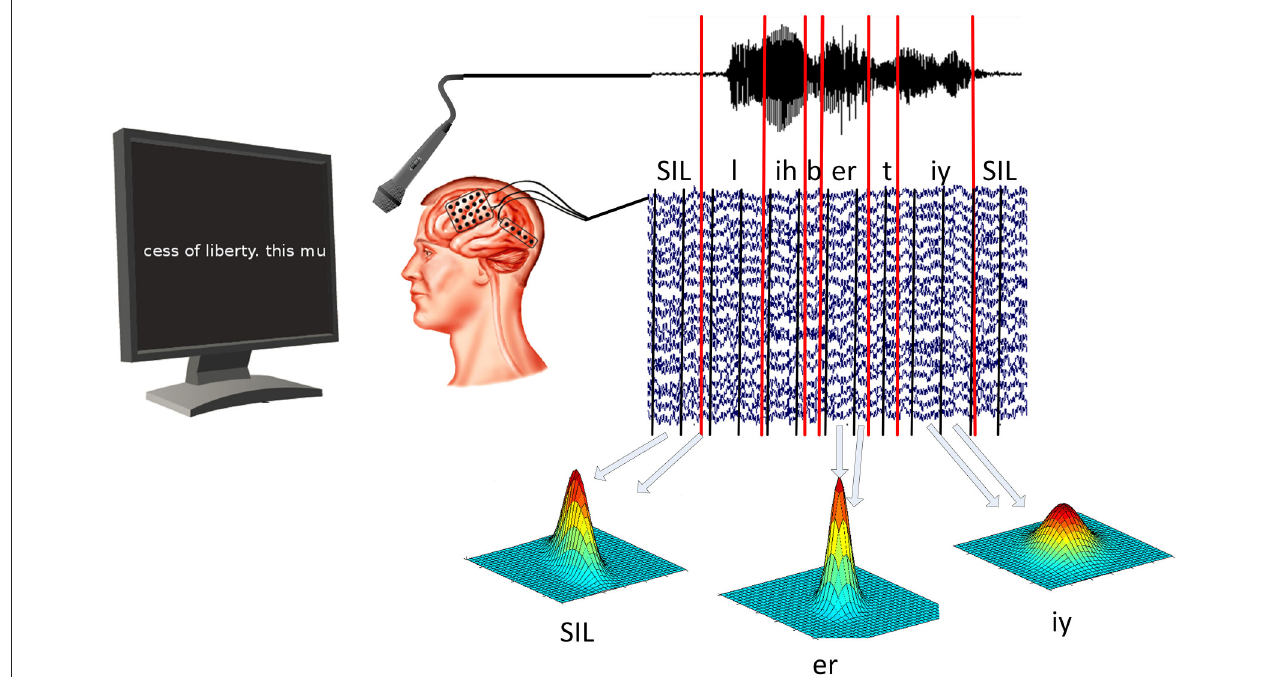
FIGURE 1 | ECoG and audio data are recorded at the same time. Speech decoding software is then used to determine timing of vowels and consonants in acoustic data. ECoG models are then trained for each phone individually by calculating the mean and covariance of all segments associated with that particular phone.